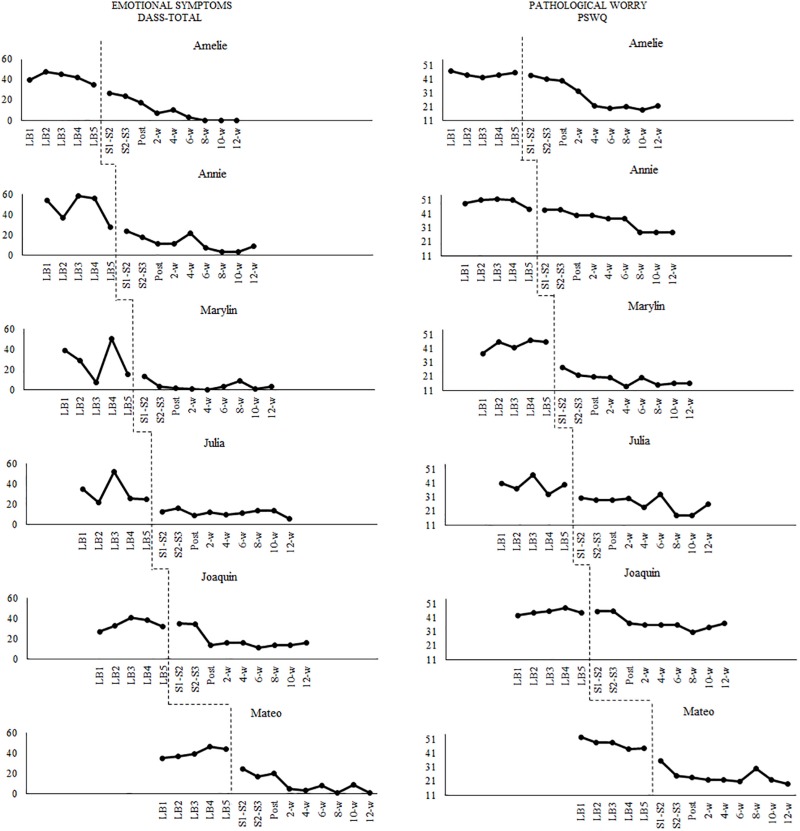
Participants’ evolution in emotional symptoms and pathological worry across the study.